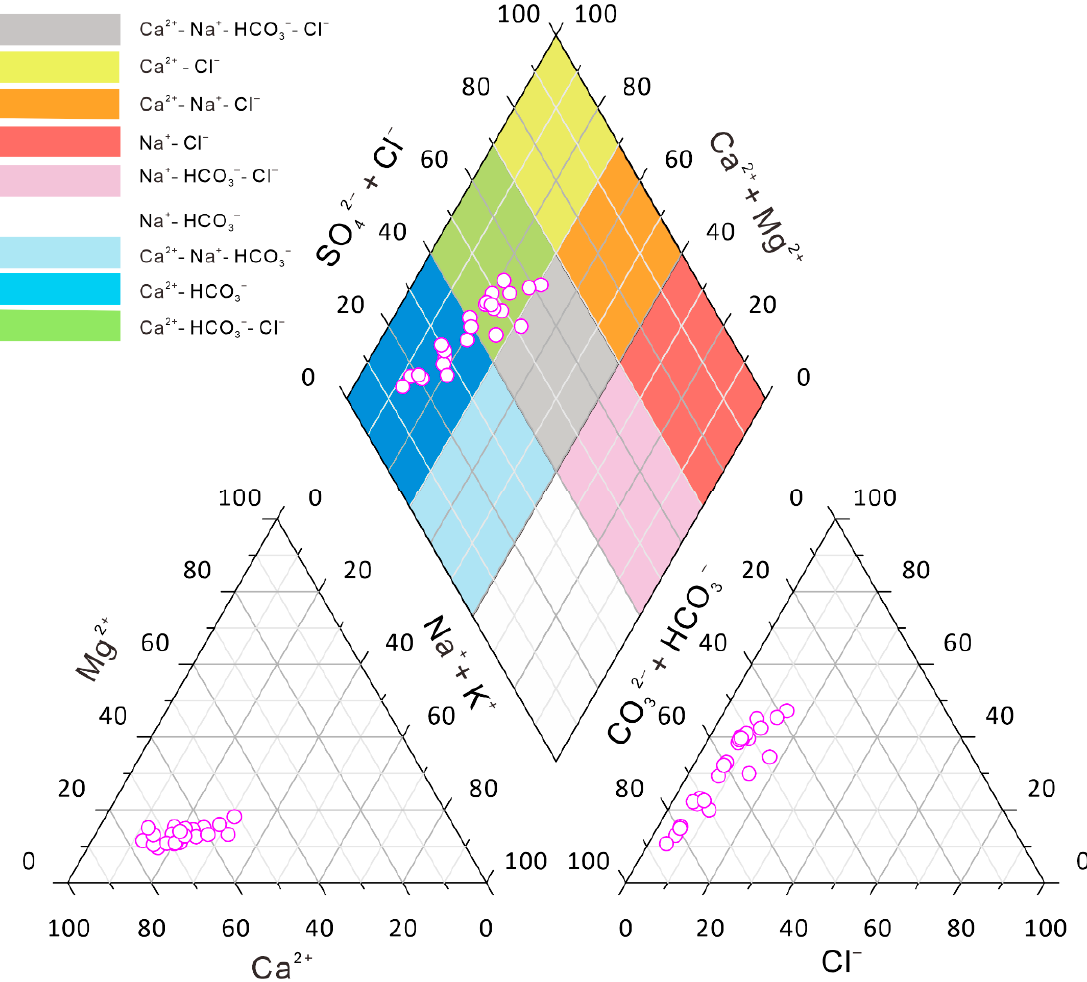
Figure 3. Piper diagram with hydrochemical types for water samples from the region of the Altay Mts.